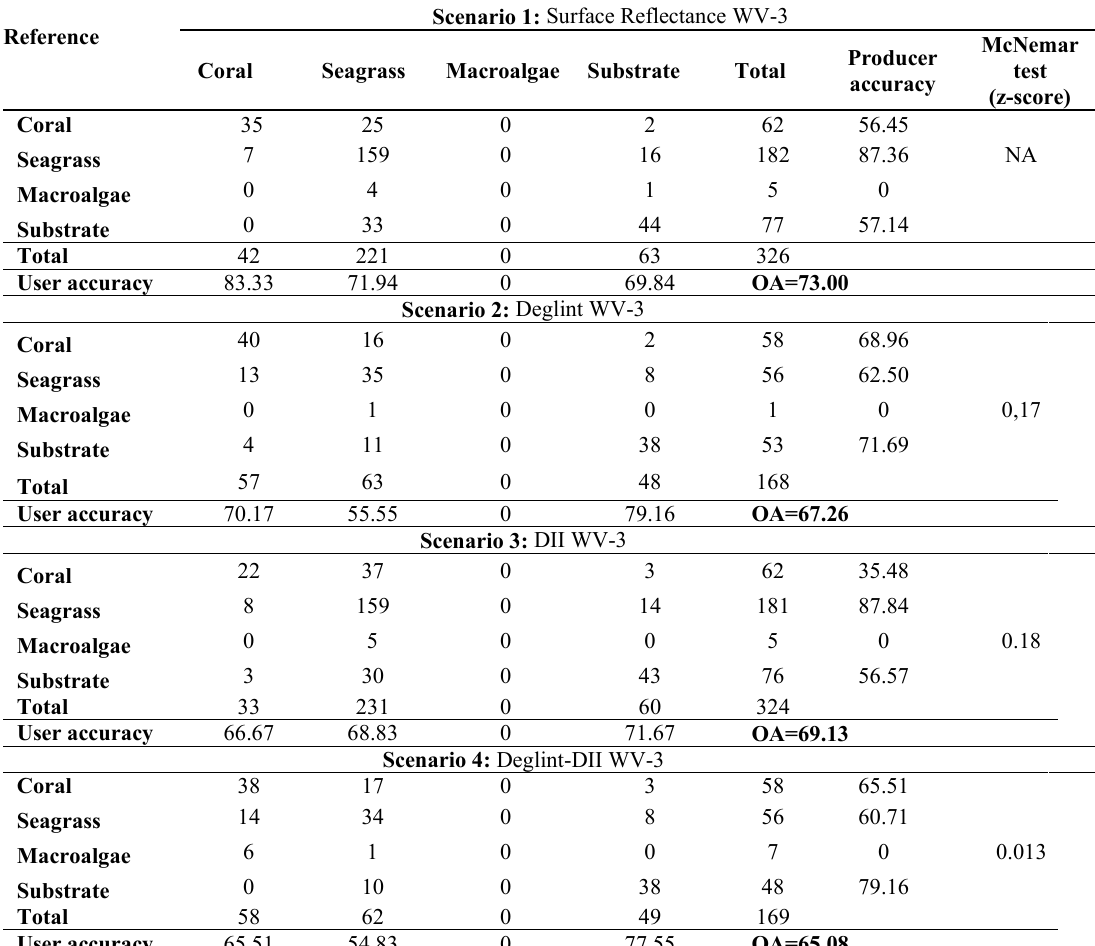
Table 3 . Confusion matrix of benthic habitat classification using random forests